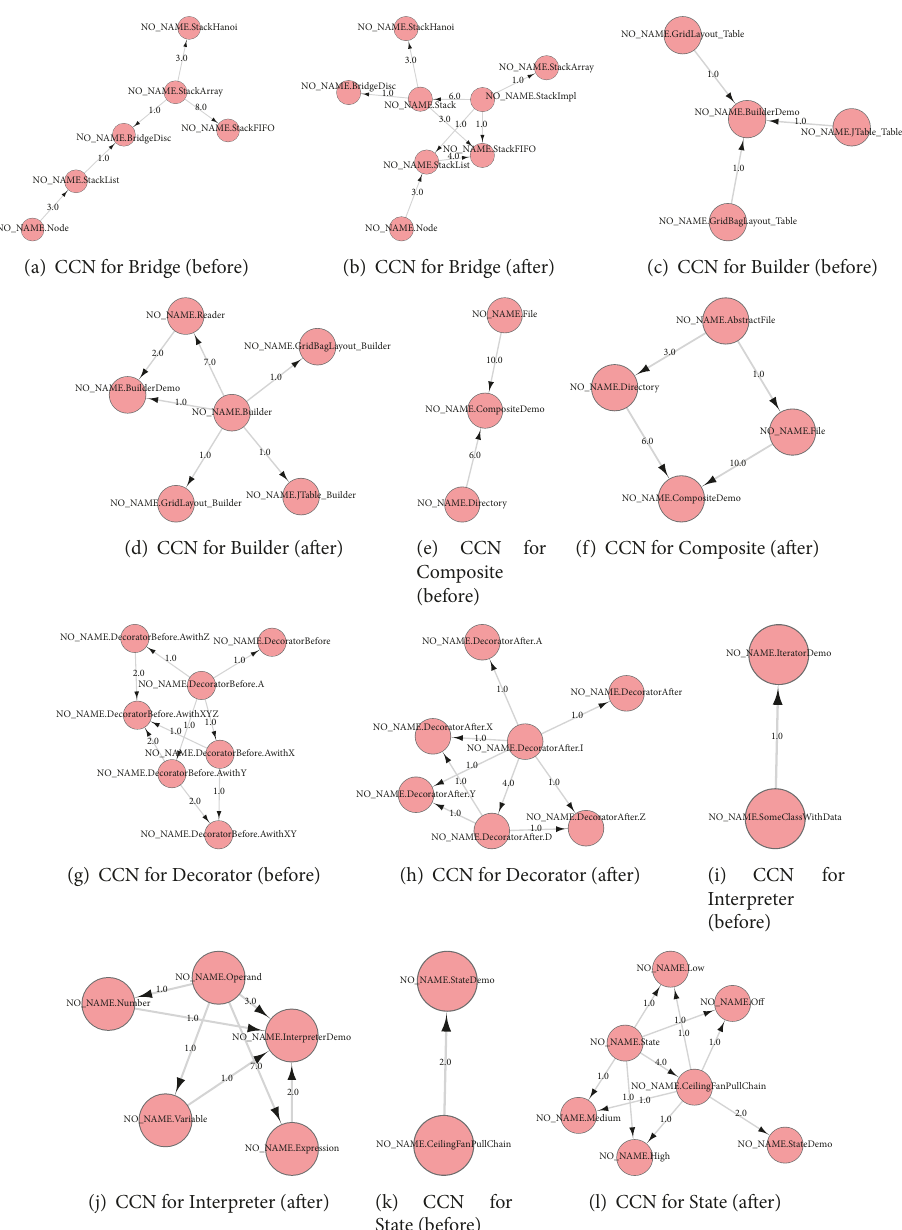
Figure 7: CCNs for the six pairs of software systems. NO NAME is the package (anonymous package) where the cor- responding class is defined. The source files of these figures can be downloaded from https://www.icloud.com/iclouddrive/ 0sSM4U7GmxiTLpLfpp0kxcDsg#complexity9414162supp